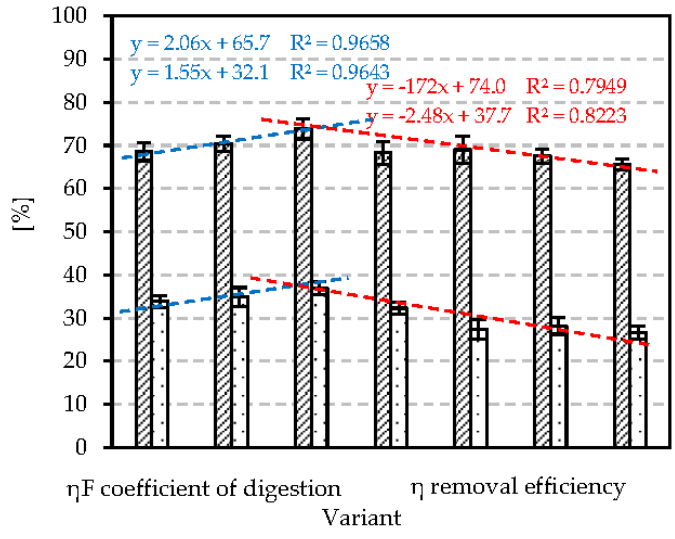
Figure 7. AD performance indicators.